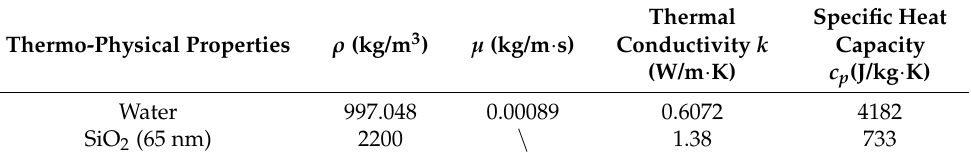
Table 2. Thermo-physical properties of the fluid and SiO 2 nanoparticle at a temperature of 298 K and under normal